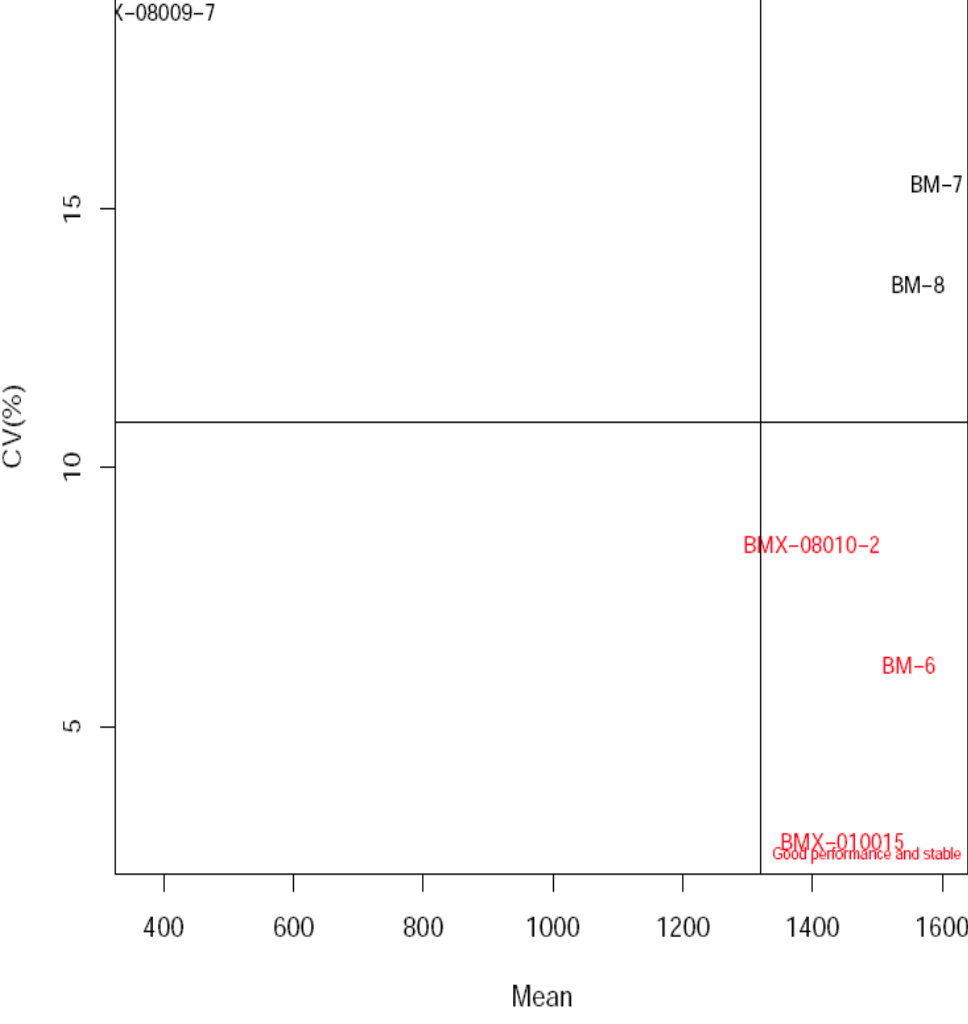
Figure 4. Biplot displaying CV (%) against mean grain yield. The genotypes BM-6, BM-7, and BM-8 stand for BARI Mung-6, BARI Mung-7, and BARI Mung-8, respectively.